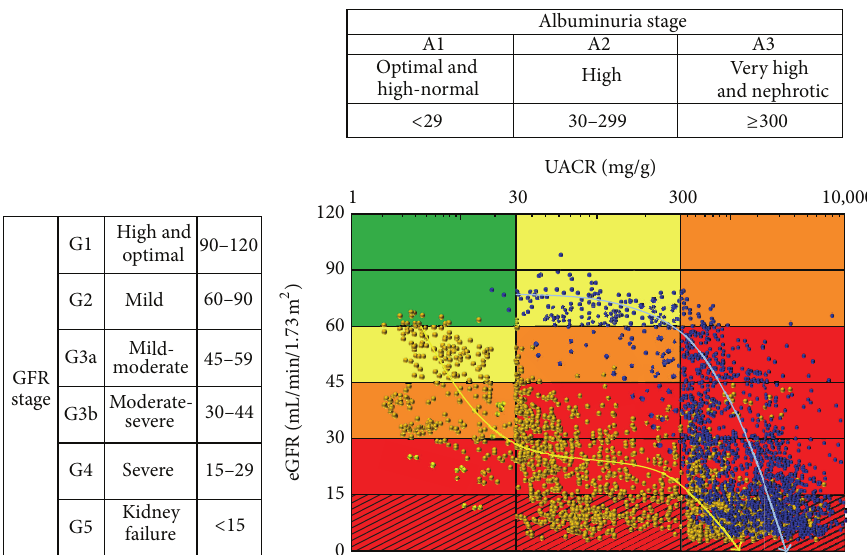
Figure 3: Data of simultaneously measured eGFR and UACR from the first visit to RRT initiation in the diabetic nephropathy group and nephrosclerosis group as represented on the KDIGO heat map. Blue and yellow bold arrows indicate clinical trajectories of the diabetic nephropathy and nephrosclerosis groups, respectively. eGFR, estimated glomerular filtration rate; GFR, glomerular filtration rate; KDIGO, Kidney Disease: Improving Global Outcomes; UACR, urinary albumin to creatinine